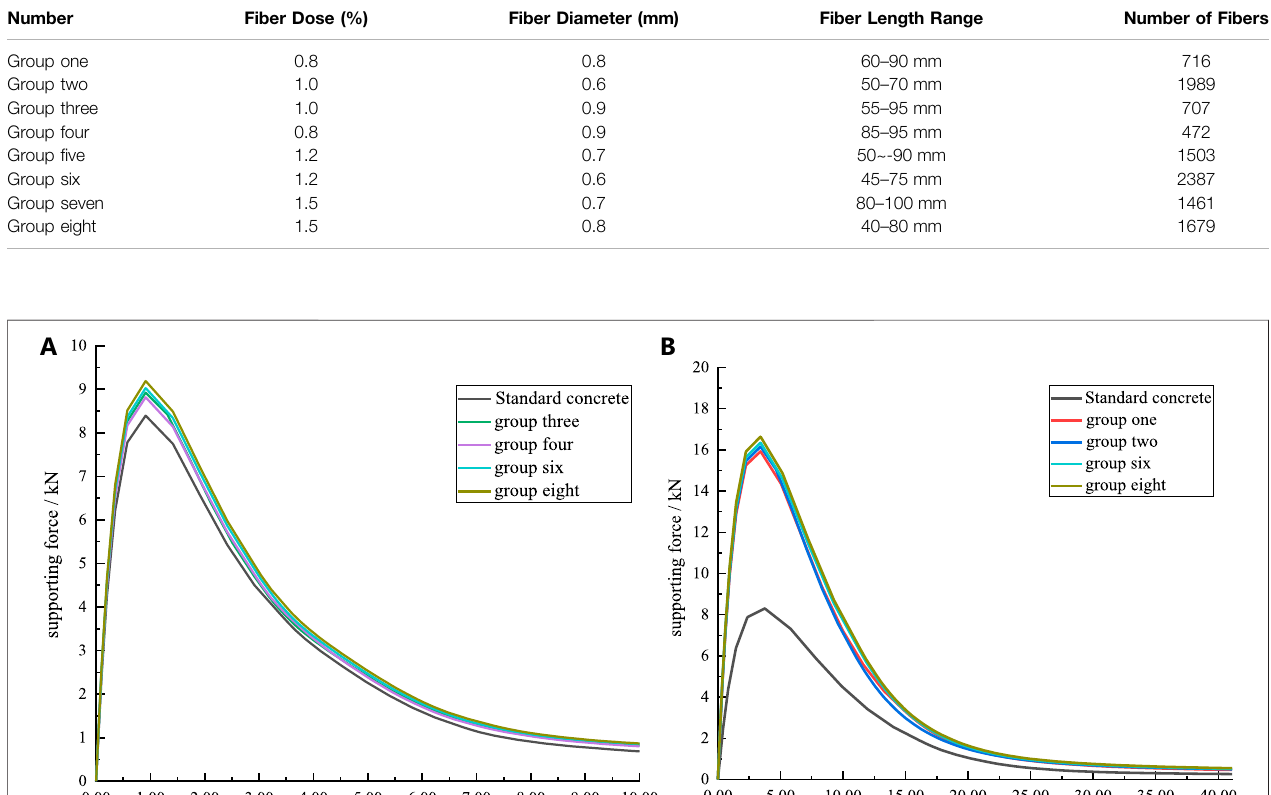
TABLE 2 | Fiber mixing scheme for each group of test blocks.